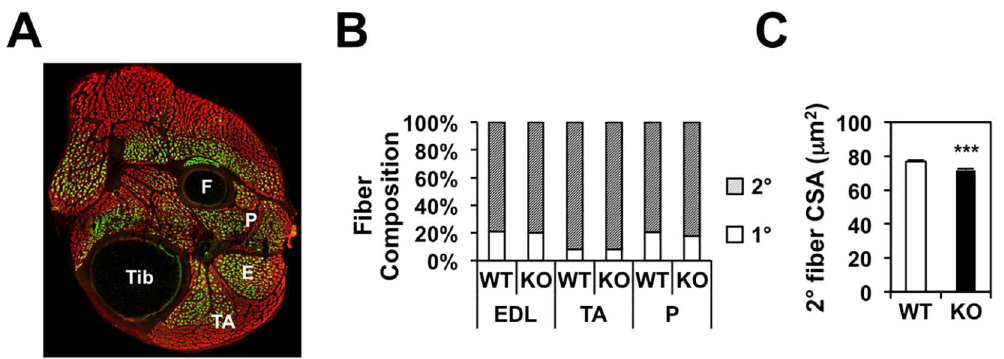
Fig 3. Nur77 deficiency reduces secondary myofiber size in E18.5 mouse hindlimb. (A) Representative immunostaining of E18.5 mouse hindlimb. Red—allmyofibers(MY32-reactive), green—primary myofibers (A4.84-reactive). Secondarymyofibers are identifiedas red fibers that were not green. F- fibula, Tib—tibialis,P— peroneus, E—EDL, TA—tibialis anterior. (B) Relativeabundanceof primary and secondary myofibers in E18.5 EDL, TA, and peroneusmuscles. (C) CSA of secondarymyofibers in the EDL. N = 7–8. *** P <